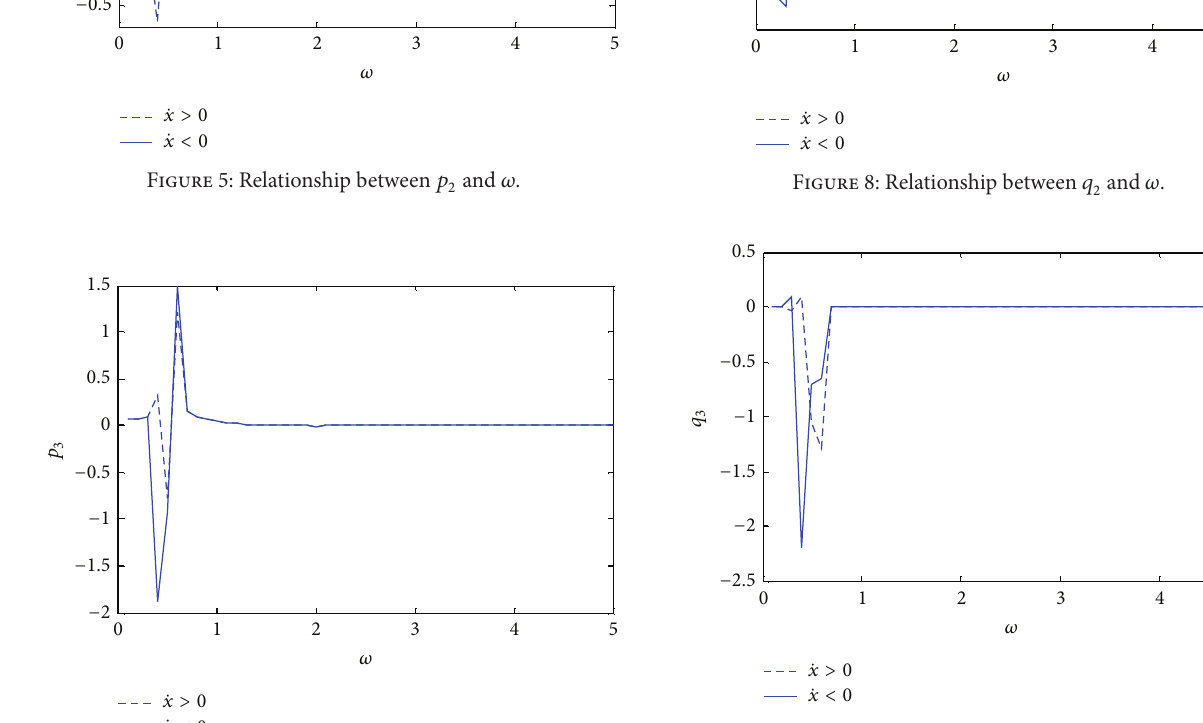
Figure 9: Relationship between 𝑞 3 and 𝜔 .